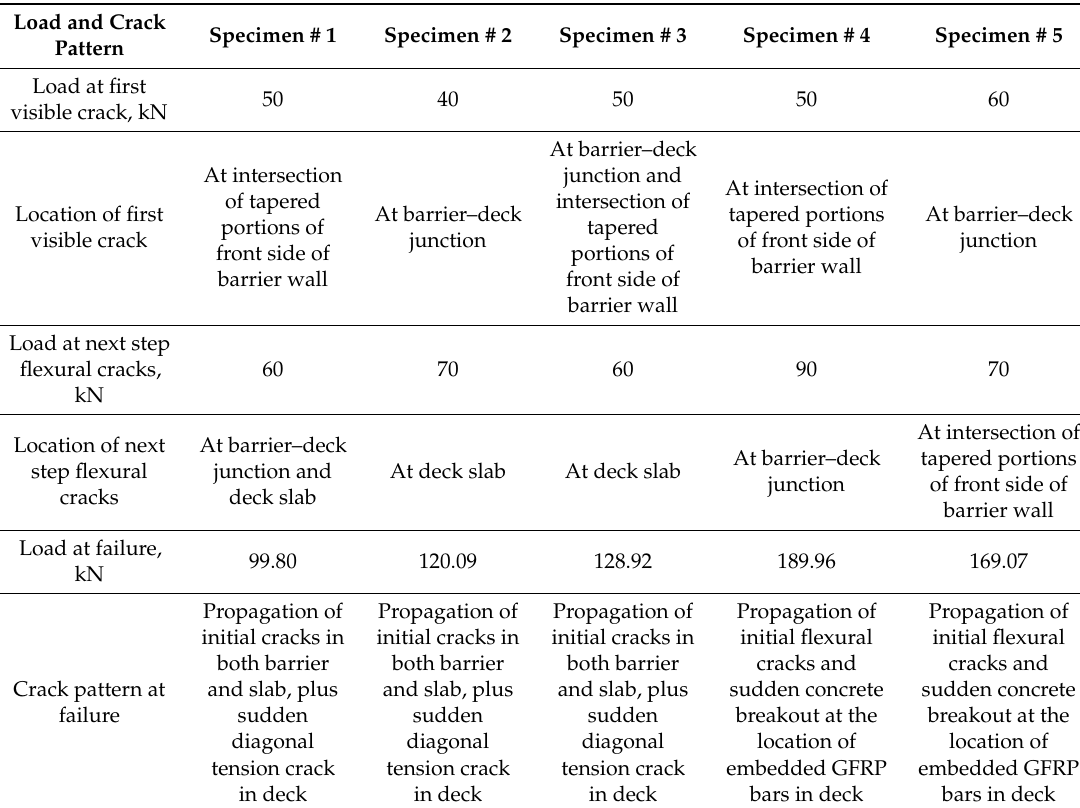
Figure 13. Specimen # 1: Load vs. concrete strain history. Table 3. Crack pattern history.